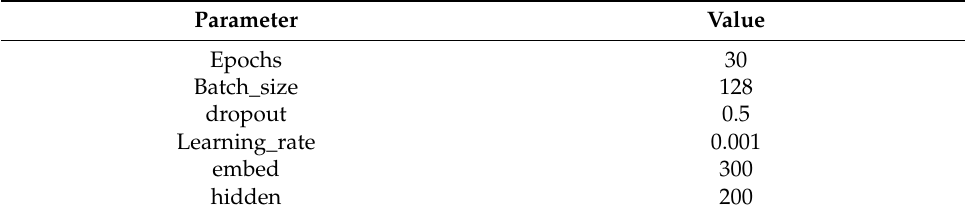
Table 2. Hyper parameter settings for entity recognition experiments.